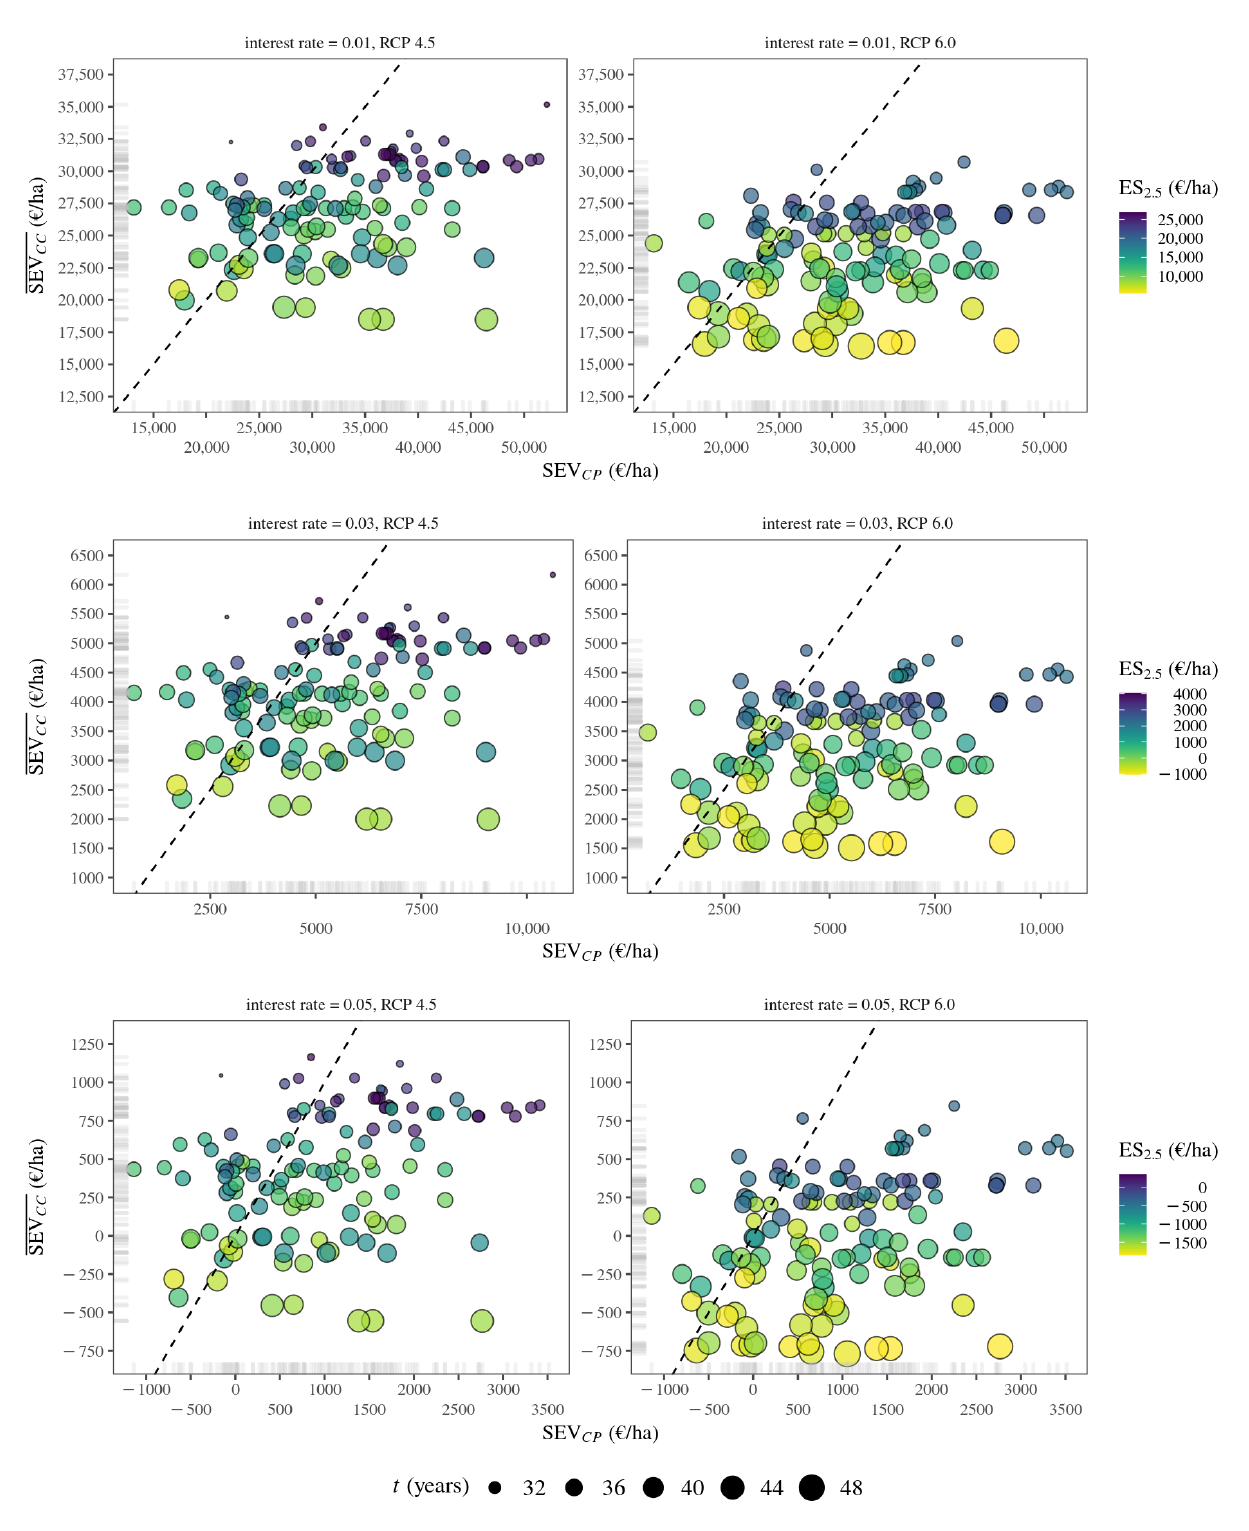
Figure 2. Scatterplots of SEV under current productivity (SEV CP ) vs. mean SEV under climate change for the two RPC’s and the three interest rates considered. The dashed line in each plot represents the